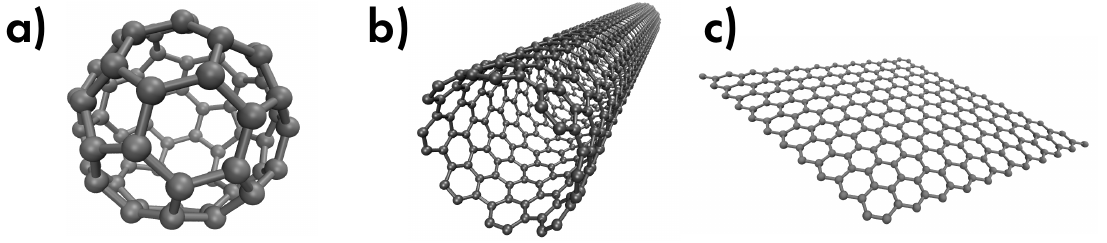
Figure 7. Ball and stick models of ( a ) fullerene, ( b ) carbon nanotubes, and ( c )